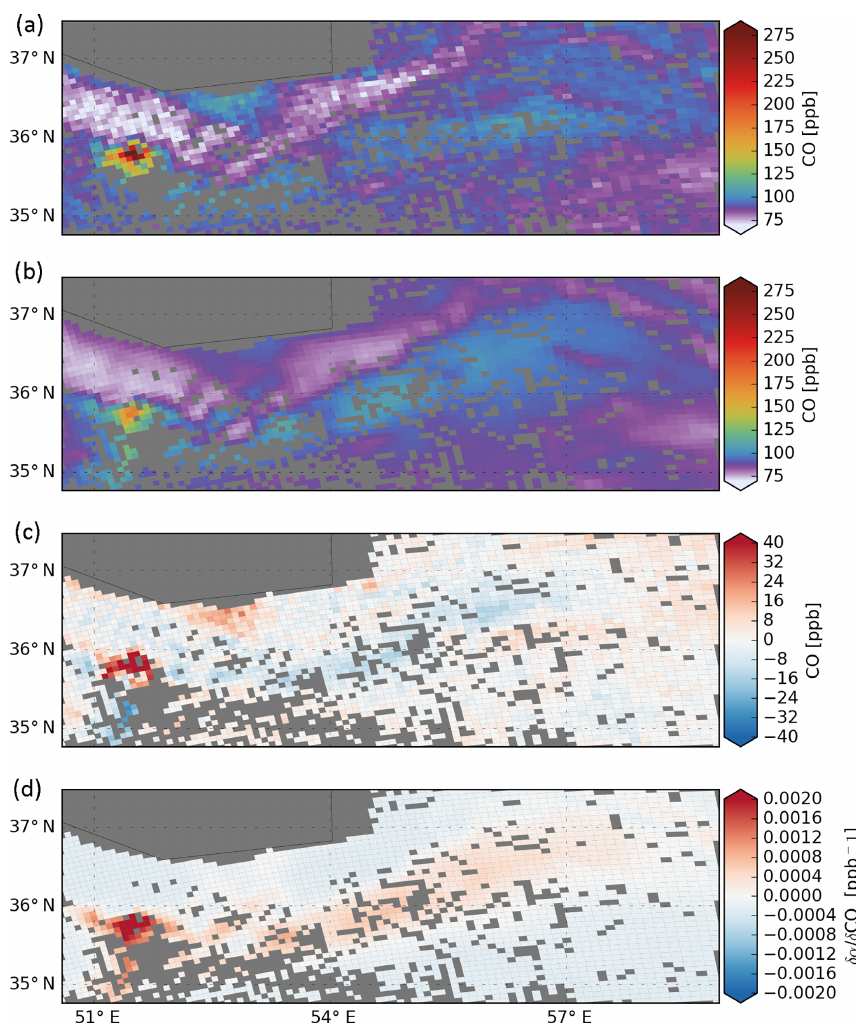
Figure 6. Same as Fig. 5 but a lager domain was used to include the pollution plume of Tehran in the eastward direction. (a–d) TROPOMI, WRF, (TROPOMI-WRF), and sensitivity of fitting the WRF data to the TROPOMI